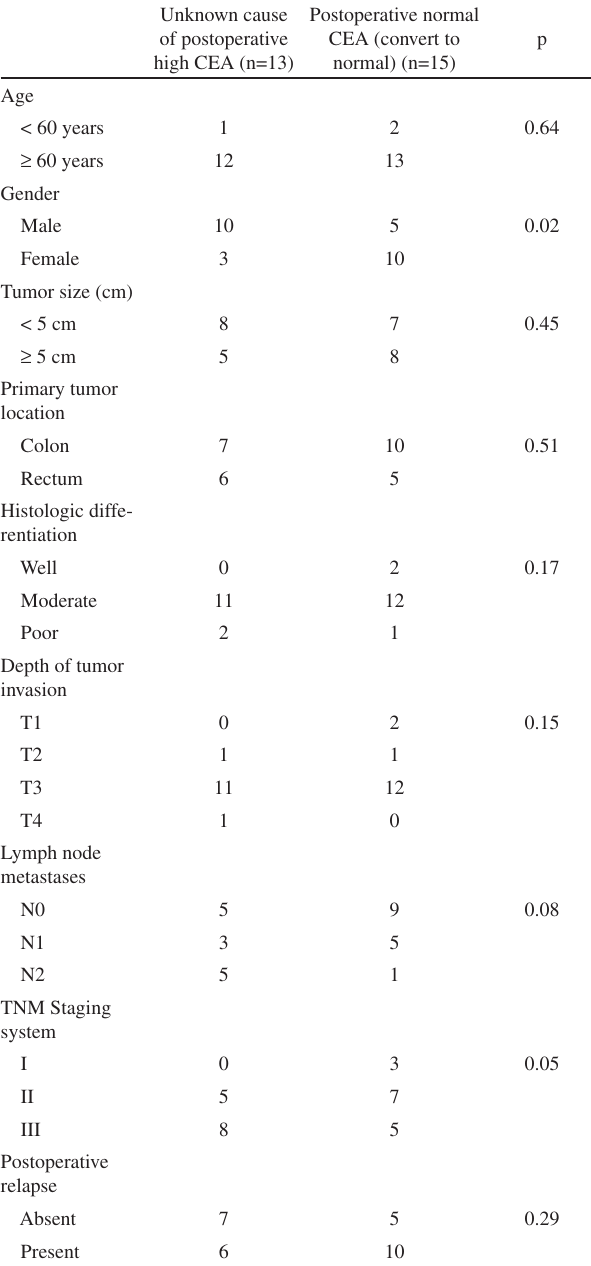
Table 4 - Comparison of characteristics in patients with abnormal preoperative serum CEA levels